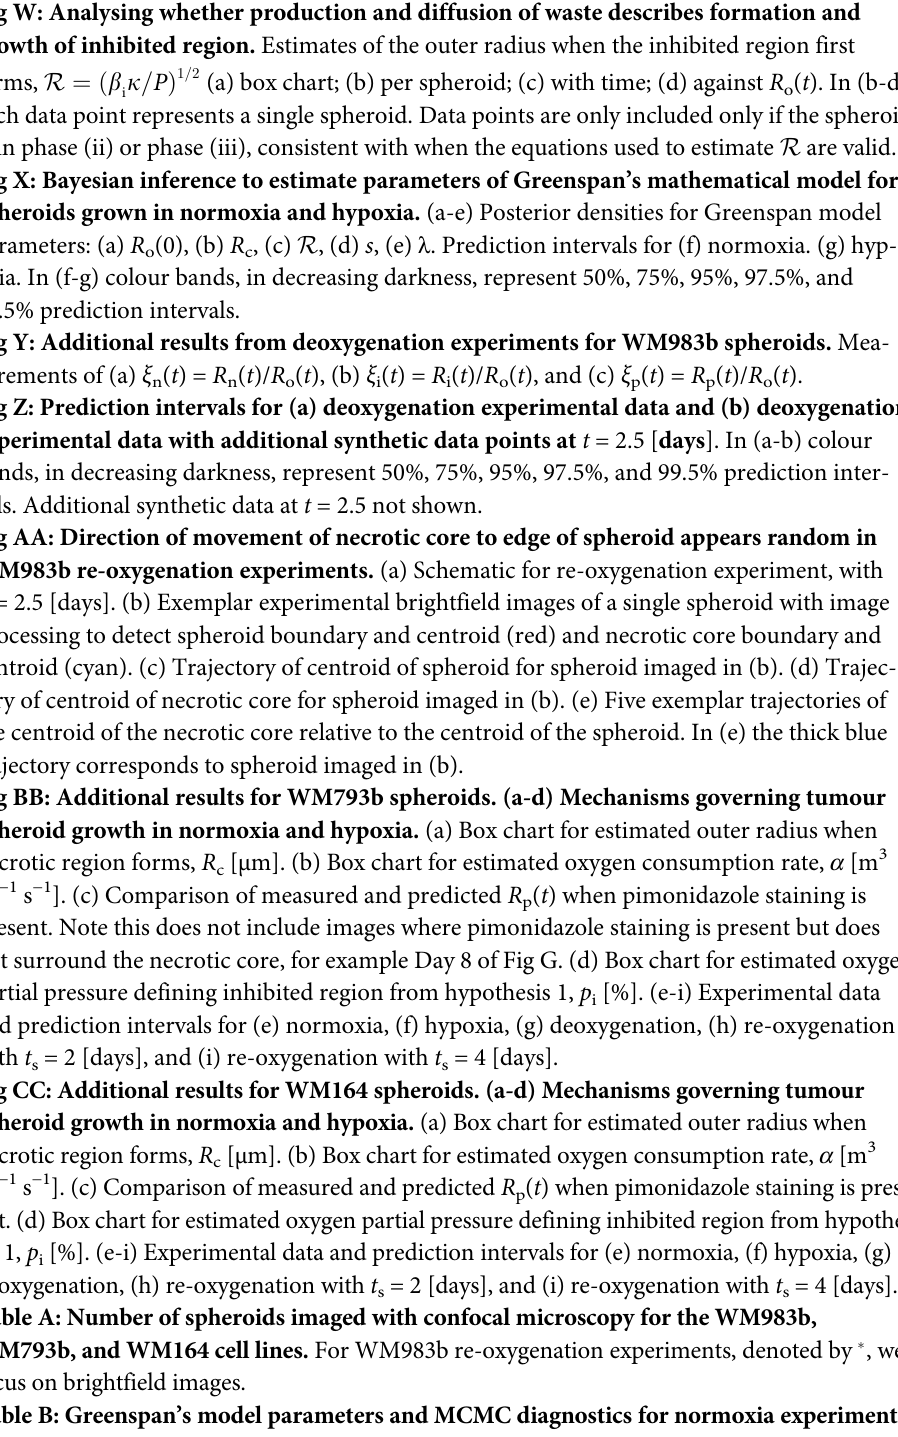
Fig W: Analysing whether production and diffusion of waste describes formation and growth of inhibited region. Estimates of the outer radius when the inhibited region first k = P Þ 1 = 2 (a) box chart; (b) per spheroid; (c) with time; (d) against R ( t ). In (b-d) forms, R ¼ ð b o i each data point represents a single spheroid. Data points are only included only if the spheroid is in phase (ii) or phase (iii), consistent with when the equations used to estimate R are valid. Fig X: Bayesian inference to estimate parameters of Greenspan’s mathematical model for spheroids grown in normoxia and hypoxia. (a-e) Posterior densities for Greenspan model parameters: (a) R (0), (b) R , (c) R , (d) s , (e) λ . Prediction intervals for (f) normoxia. (g) hyp- o c oxia. In (f-g) colour bands, in decreasing darkness, represent 50%, 75%, 95%, 97.5%, and 99.5% prediction intervals. Fig Y: Additional results from deoxygenation experiments for WM983b spheroids. Mea- surements of (a) ξ ( t ) = R ( t )/ R ( t ), (b) ξ ( t ) = R ( t )/ R ( t ), and (c) ξ ( t ) = R ( t )/ R ( t ). n n o i i o p p o Fig Z: Prediction intervals for (a) deoxygenation experimental data and (b) deoxygenation experimental data with additional synthetic data points at t = 2.5 [ days ]. In (a-b) colour bands, in decreasing darkness, represent 50%, 75%, 95%, 97.5%, and 99.5% prediction inter- vals. Additional synthetic data at t = 2.5 not shown. Fig AA: Direction of movement of necrotic core to edge of spheroid appears random in WM983b re-oxygenation experiments. (a) Schematic for re-oxygenation experiment, with t s = 2.5 [days]. (b) Exemplar experimental brightfield images of a single spheroid with image processing to detect spheroid boundary and centroid (red) and necrotic core boundary and centroid (cyan). (c) Trajectory of centroid of spheroid for spheroid imaged in (b). (d) Trajec- tory of centroid of necrotic core for spheroid imaged in (b). (e) Five exemplar trajectories of the centroid of the necrotic core relative to the centroid of the spheroid. In (e) the thick blue trajectory corresponds to spheroid imaged in (b). Fig BB: Additional results for WM793b spheroids. (a-d) Mechanisms governing tumour spheroid growth in normoxia and hypoxia. (a) Box chart for estimated outer radius when necrotic region forms, R [ μ m]. (b) Box chart for estimated oxygen consumption rate, α [m 3 c kg − 1 s − 1 ]. (c) Comparison of measured and predicted R ( t ) when pimonidazole staining is p present. Note this does not include images where pimonidazole staining is present but does not surround the necrotic core, for example Day 8 of Fig G. (d) Box chart for estimated oxygen partial pressure defining inhibited region from hypothesis 1, p [%]. (e-i) Experimental data i and prediction intervals for (e) normoxia, (f) hypoxia, (g) deoxygenation, (h) re-oxygenation with t = 2 [days], and (i) re-oxygenation with t = 4 [days]. s s Fig CC: Additional results for WM164 spheroids. (a-d) Mechanisms governing tumour spheroid growth in normoxia and hypoxia. (a) Box chart for estimated outer radius when necrotic region forms, R [ μ m]. (b) Box chart for estimated oxygen consumption rate, α [m 3 c kg − 1 s − 1 ]. (c) Comparison of measured and predicted R ( t ) when pimonidazole staining is pres- p ent. (d) Box chart for estimated oxygen partial pressure defining inhibited region from hypothe- sis 1, p [%]. (e-i) Experimental data and prediction intervals for (e) normoxia, (f) hypoxia, (g) i deoxygenation, (h) re-oxygenation with t = 2 [days], and (i) re-oxygenation with t = 4 [days]. s s Table A: Number of spheroids imaged with confocal microscopy for the WM983b, WM793b, and WM164 cell lines. For WM983b re-oxygenation experiments, denoted by � , we focus on brightfield images. Table B: Greenspan’s model parameters and MCMC diagnostics for normoxia experiments. Summary statistics of the MCMC chains include: mean; standard deviation, σ ; and, 25%, 50%, and 75% quartiles, Q , Q , and Q , respectively. To assess convergence of the 25% 50% 75%